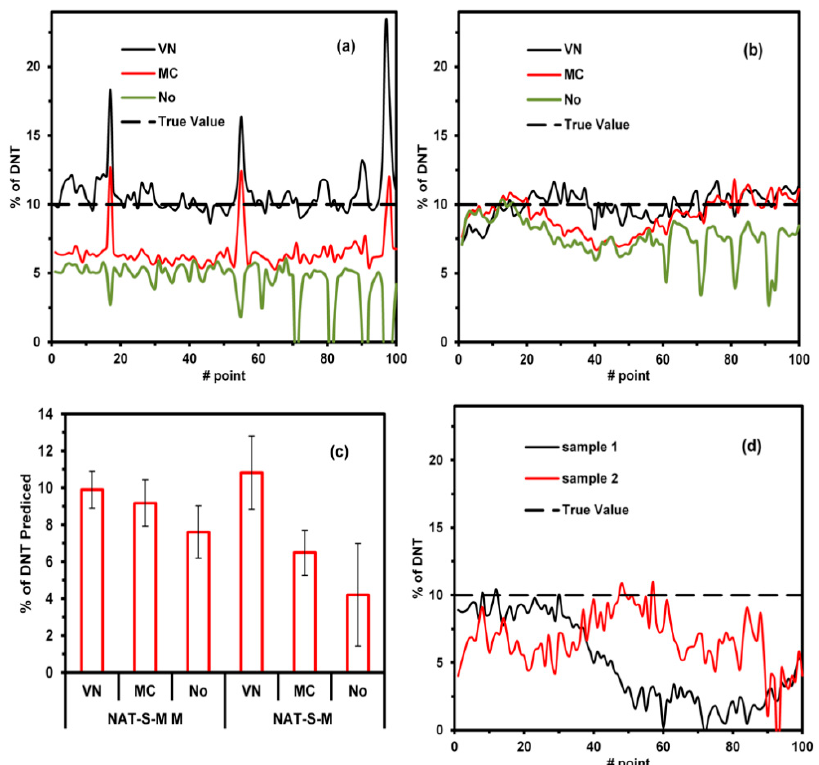
Figure 4. Predictions for 100 pts. maps after applying VN, mean centering (MC), and no preprocessing: ( a ) simple mixture (NAT-S-M); ( b ) macerating the components (NAT-S-MM); ( c ) Averages for the predictions of NAT-S-M and NAT-S-MM ( d ) NAT2-S with VN